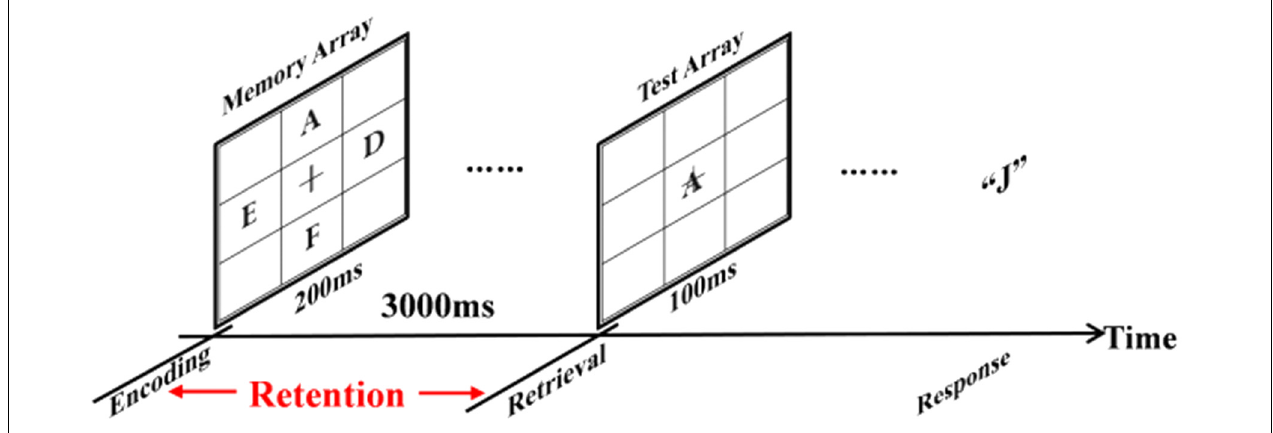
FIGURE 1 | An example of the stimulus sequence in the experiment. Each trial started with a fixation cross (0.5 ◦ × 0.5 ◦ ) at the center of the monitor flashing for 50 ms. Next, the memory array with two, four or eight letters (0.5 ◦ × 0.5 ◦ ) was presented for 200 ms. After 3000 ms retention interval, a probe item was presented for 100 ms and subjects responded with a button press, pointing out if the probe item once was presented in the memory